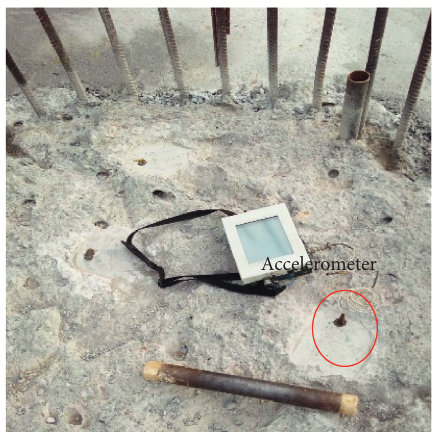
Figure 10: Setup of the LST.